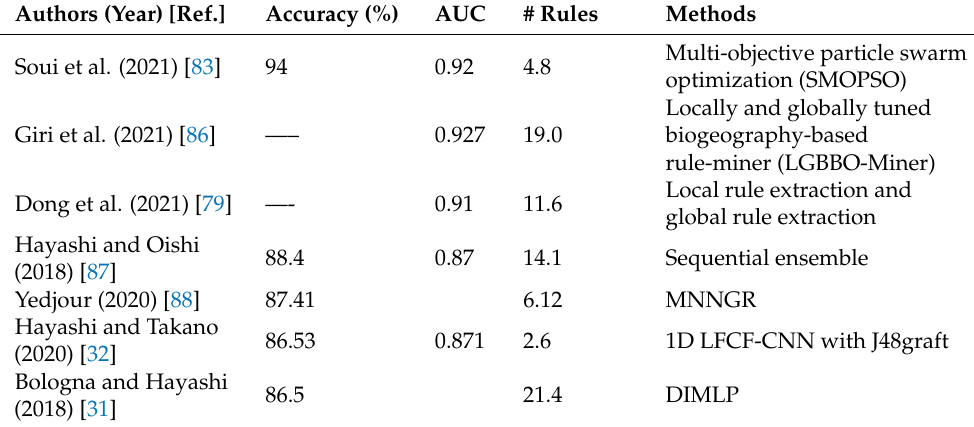
Table 14. Performance of rule extraction methods and rule-based classifiers for the Australian dataset. Authors (Year)